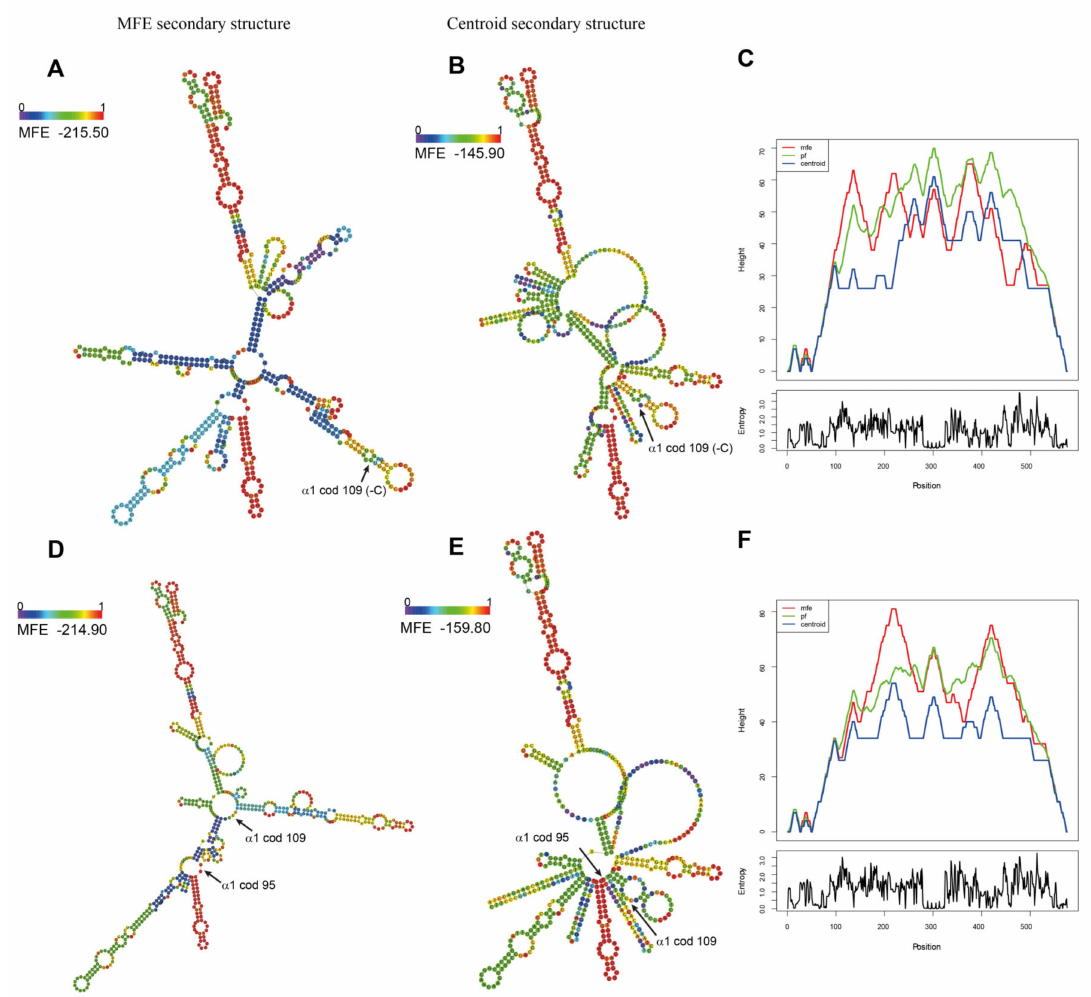
Figure 8. Secondary structure of α 1-globin mRNAs predicted by the RNAfold web server. ( A , B , C ) α 1 cod109 ( − C) mRNA. ( D , E , F ) WT α 1-globin mRNA. ( A , D ) Minimum free energy (MFE) secondary structure. ( B , E ) Centroid secondary structure with the corresponding values. ( C , F ) Mountain plot representation of the MFE structure for each α 1-globin mRNA. The values of α 1 cod109 ( − C) presented a small variation in free energy of the secondary structure. The centroid secondary structure of α 1 cod109 ( − C) presented a variation in free energy. The presence of differences in the secondary structure conformation of the α 1 cod109 ( − C) mRNA could alter the access of the ribosomal